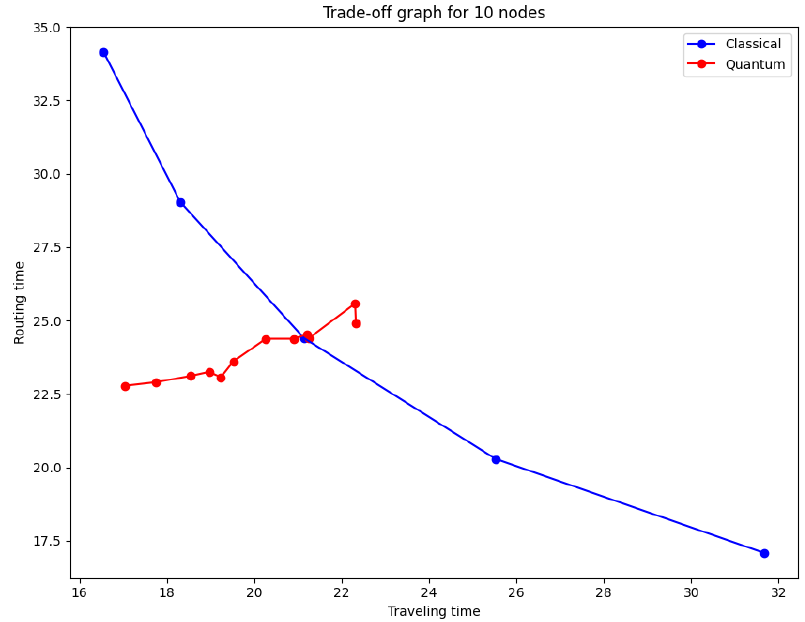
Figure 10. Effect of decoherence in the trade-off barrier by quantum protocol. As the value of C moves away from C = 1 (ideal case), the quantum case looks more and more like the classical case. p values between 0.3 and